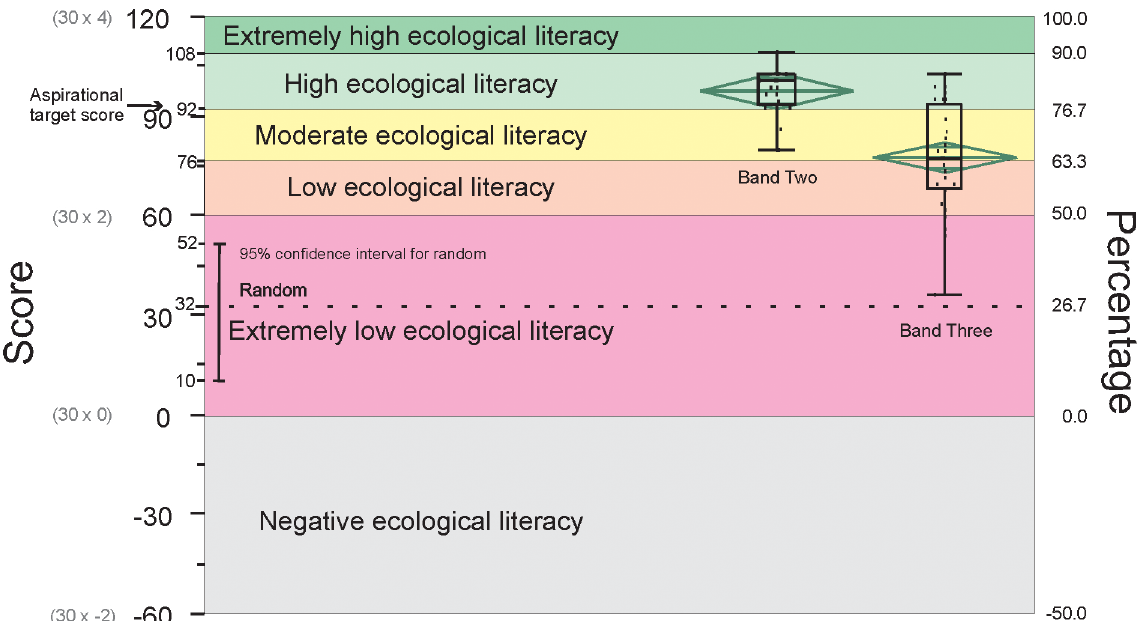
Fig 2. Standards system for ecological knowledge and understanding determined through the benchmarking process. Scores out of 120 are also shown as percentages. The expected score for random choice answers is 32. Band Two and Three results are shown in relation to the